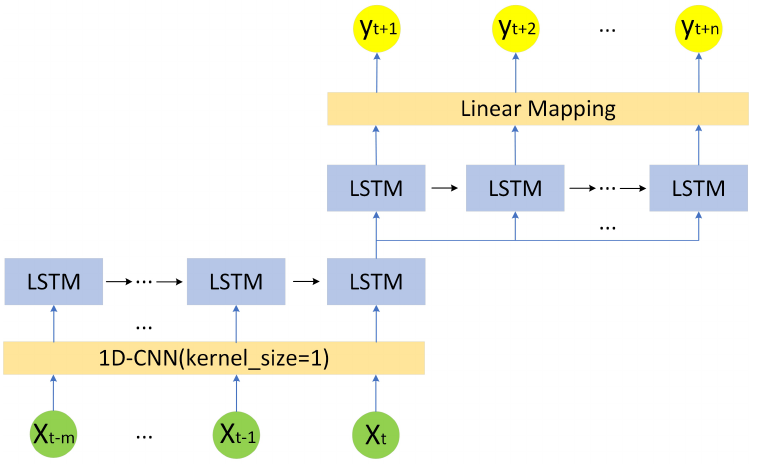
Figure 8. This is the multi-step LSTM prediction